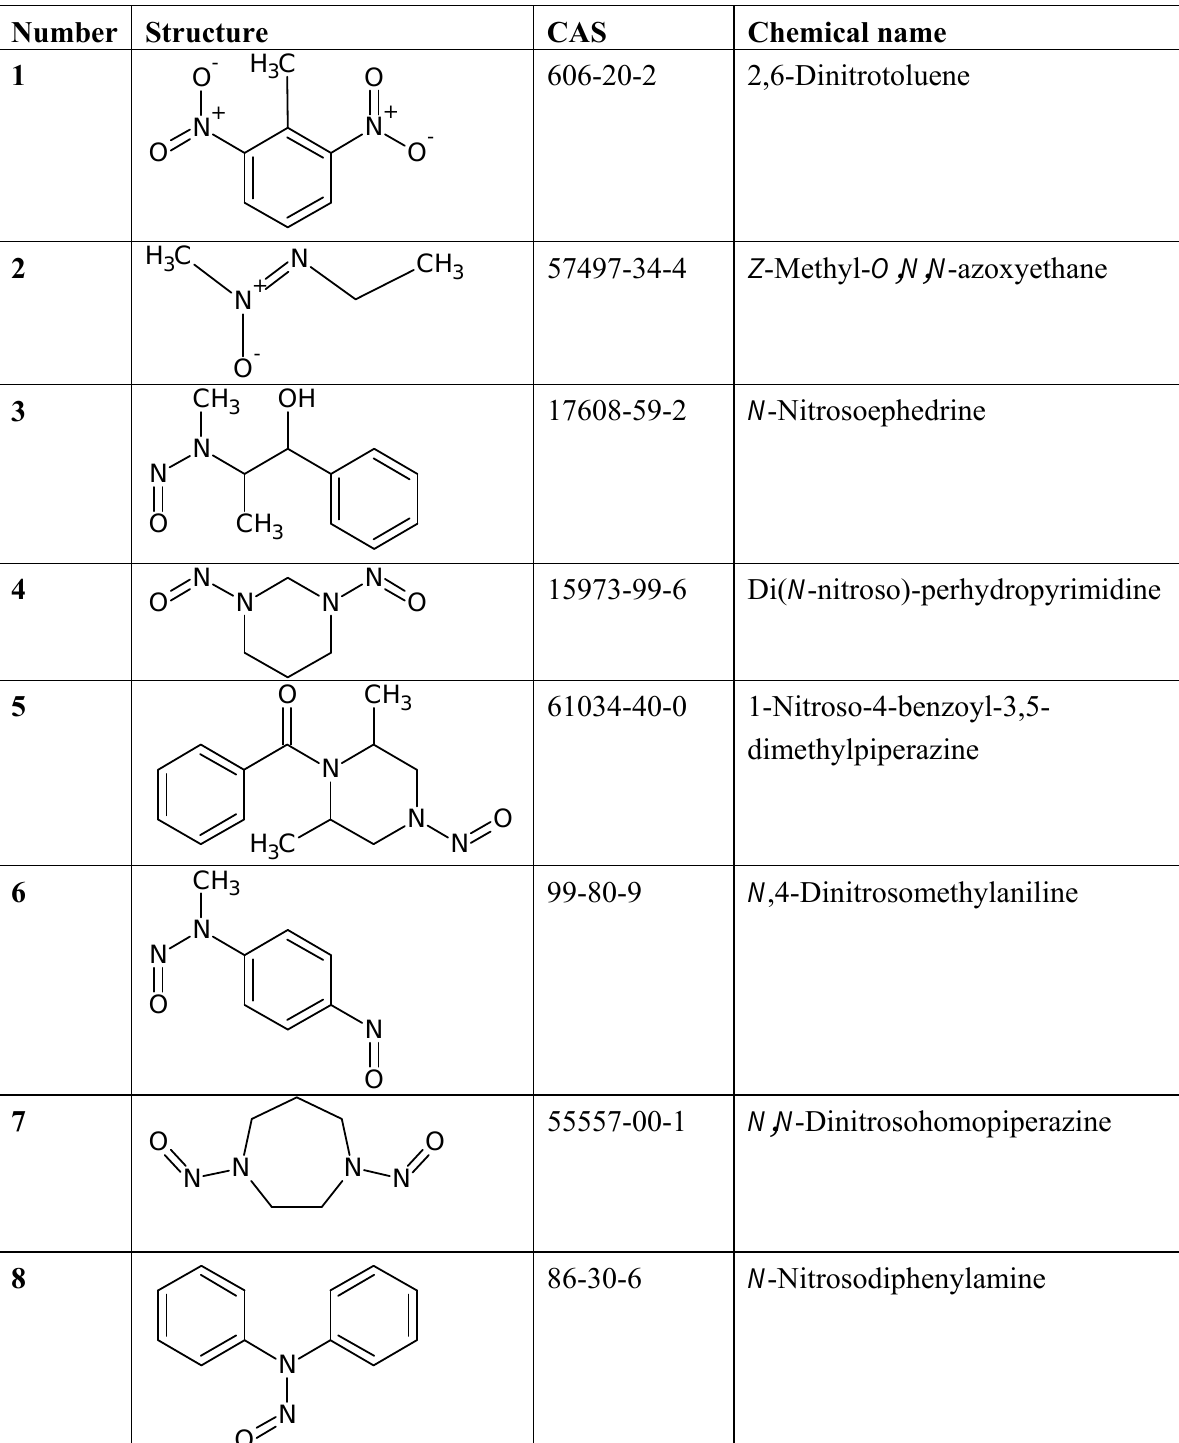
Table 1. The list of outliers of the QSAR models calculated with SMILES-based optimal